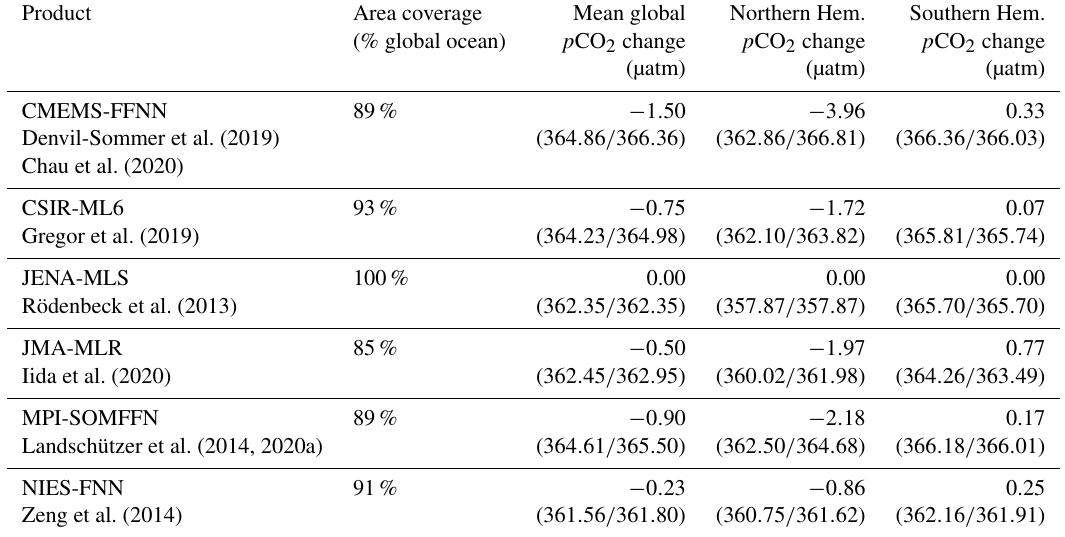
Table 1. Global area coverage and mean p CO 2 for the six observation-based products. Area coverage listed represents the average annual area covered for 1990–2019 as this value changes monthly for many products (Fig. A1). Change is defined as the filled product minus original product (i.e., a negative change implies the original product had a larger global/regional mean p CO 2 than the filled product). Global and hemispheric mean p CO 2 values for filled/original coverage are included in parentheses below the delta value. Product Area coverage Mean global Northern